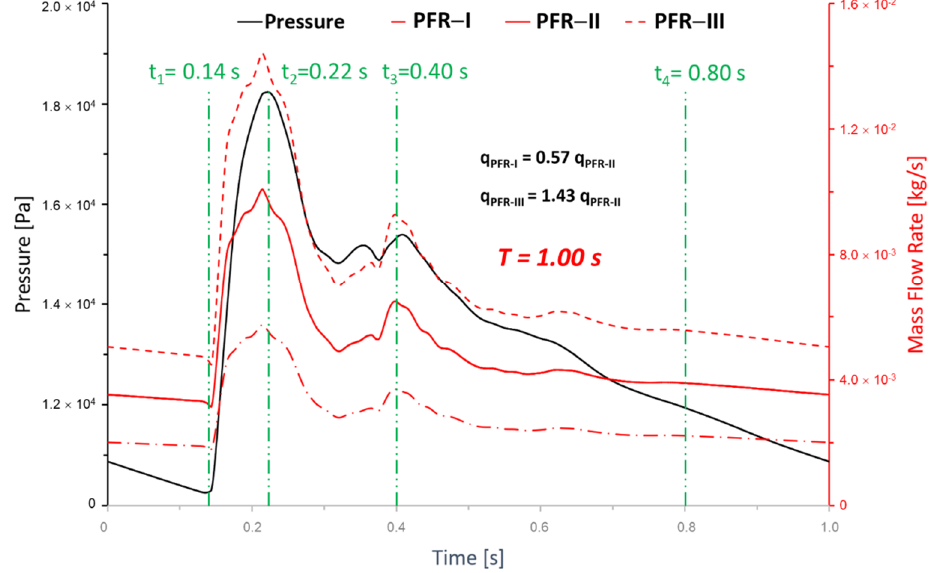
Figure 3. Transient pulsatile flow rate boundary conditions at the internal carotid artery (ICA) inlet. 2.5. Time-Averaged Pressure ( (cid:1846)(cid:1827)(cid:1842)